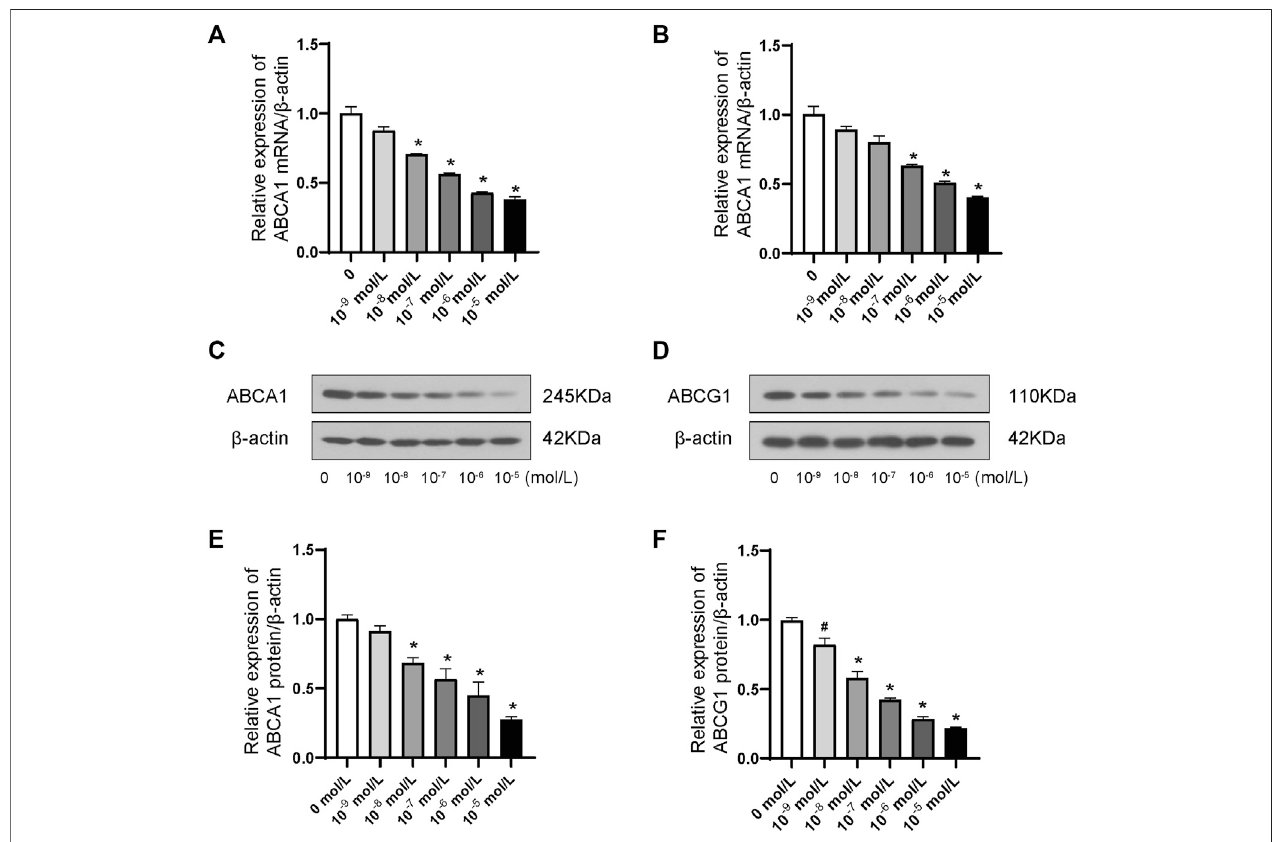
FIGURE2| Dose-dependenteffectsofANPdownregulatedABCA1andABCG1inTHP-1macrophages.A:ANPinconcentrationsrangingfrom10 − 9 to10 − 5 mol/ L inhibited the ABCA1 mRNA expression in a dose-dependent manner ( n (cid:1) 3). B: ANP in concentrations ranging from 10 − 9 to 10 − 5 mol/L suppressed ABCG1 mRNA expression inadose-dependentmanner.CandE:ANPinconcentrationsranging from10 − 9 to10 − 5 mol/Linhibited theABCA1proteinexpression inadose-dependent manner. D and F: ANP in concentrations ranging from 10 − 9 to 10 − 5 mol/L suppressed ABCG1 protein expression in a dose-dependent manner. # p < 0.05, compared with the control group. * p < 0.01, compared with the control group.